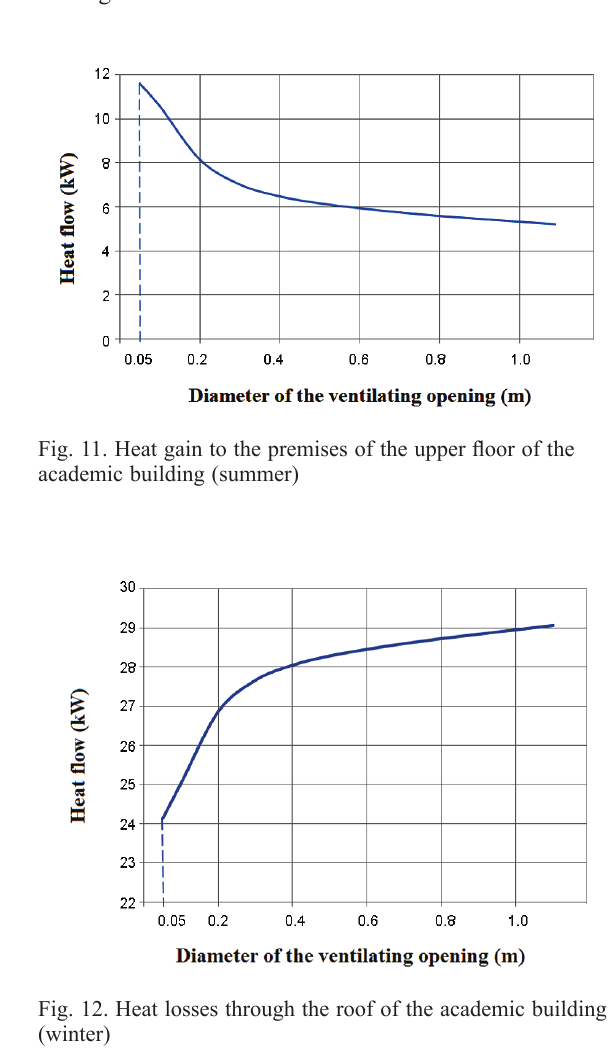
Table 4. Initial data for the calculations of the attic space of the academic building Internal air temperature for the winter and summer seasons (°C) External air temperature for the winter (°C) T e = – 20